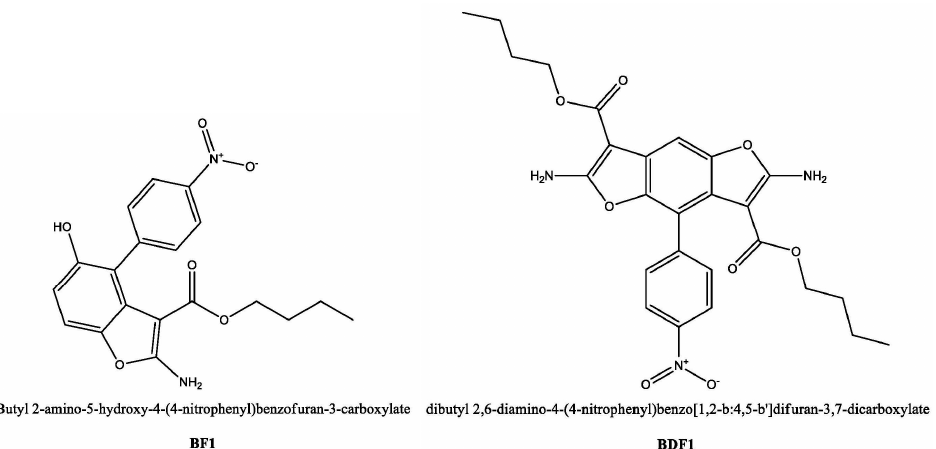
Figure 1. Chemical structures for the compounds studied as protein ligands in the current